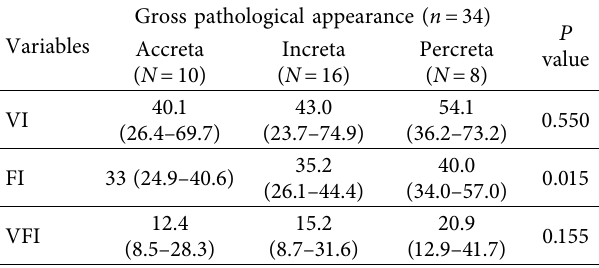
Table 1: Characteristics of subjects. Table 2: Vascularity index on gross pathological